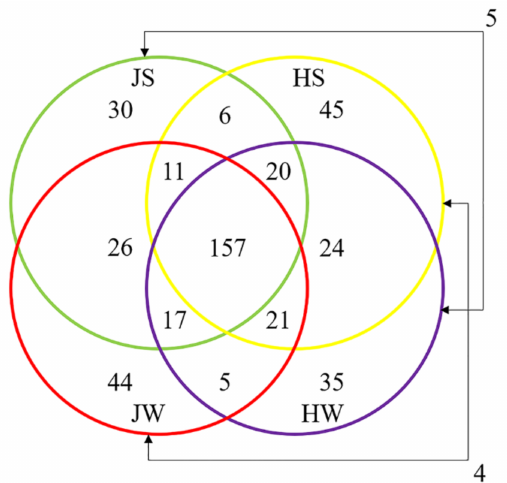
Figure 4. Venn diagram illustrating the number of unique and shared ASVs among Jamaican field and house cricket samples. JS—Jamaican cricket surface, JW—Jamaican cricket whole-body, HS—house cricket surface, HW—house cricket